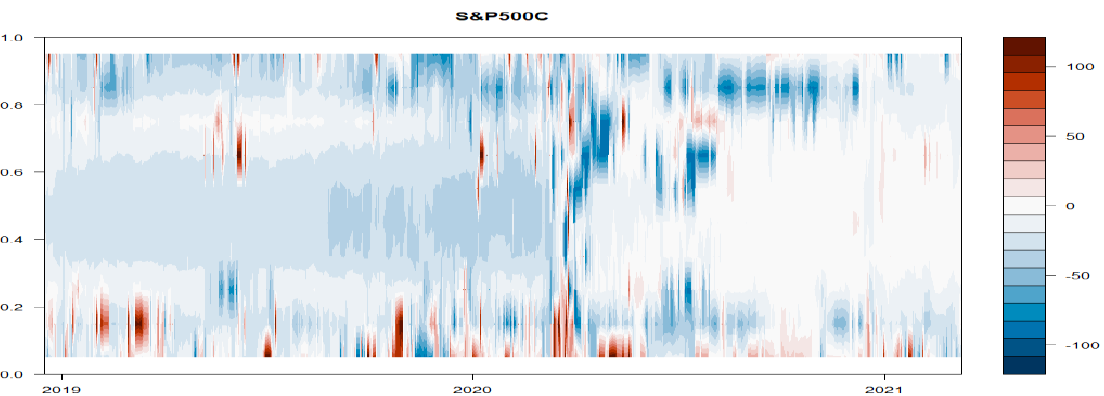
Figure 11. Results for net total directional connectedness for the S&P 500 Composite Index based on a 200-day rolling-window QVAR(1) model and a 20-step-ahead forecast.